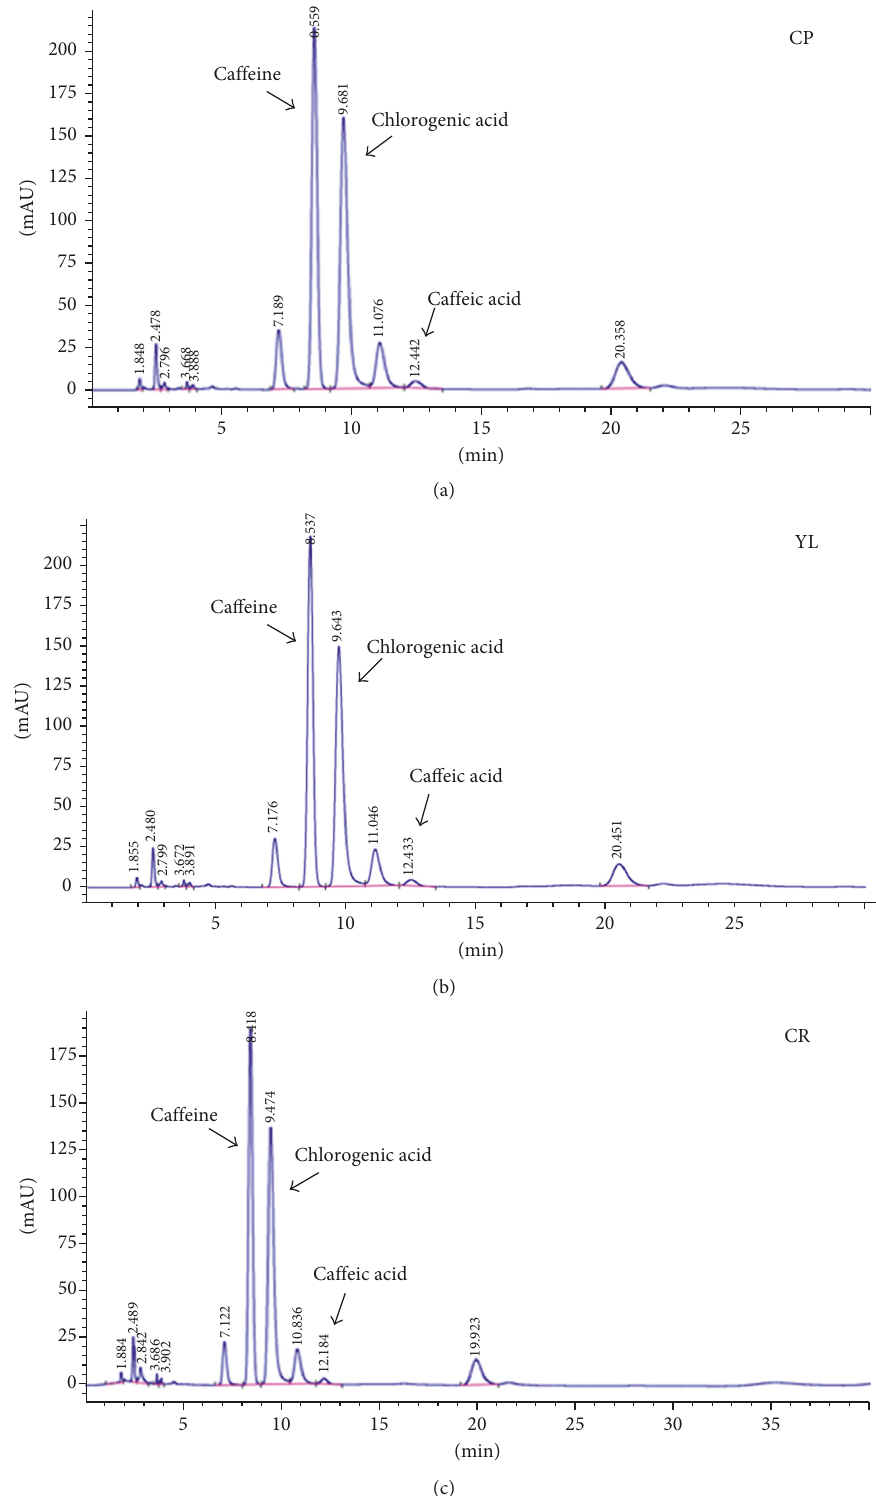
Figure 1: HPLC chromatograms of extracts: (a) CP, (b) YL, and (c) CR using HPLC at a wavelength